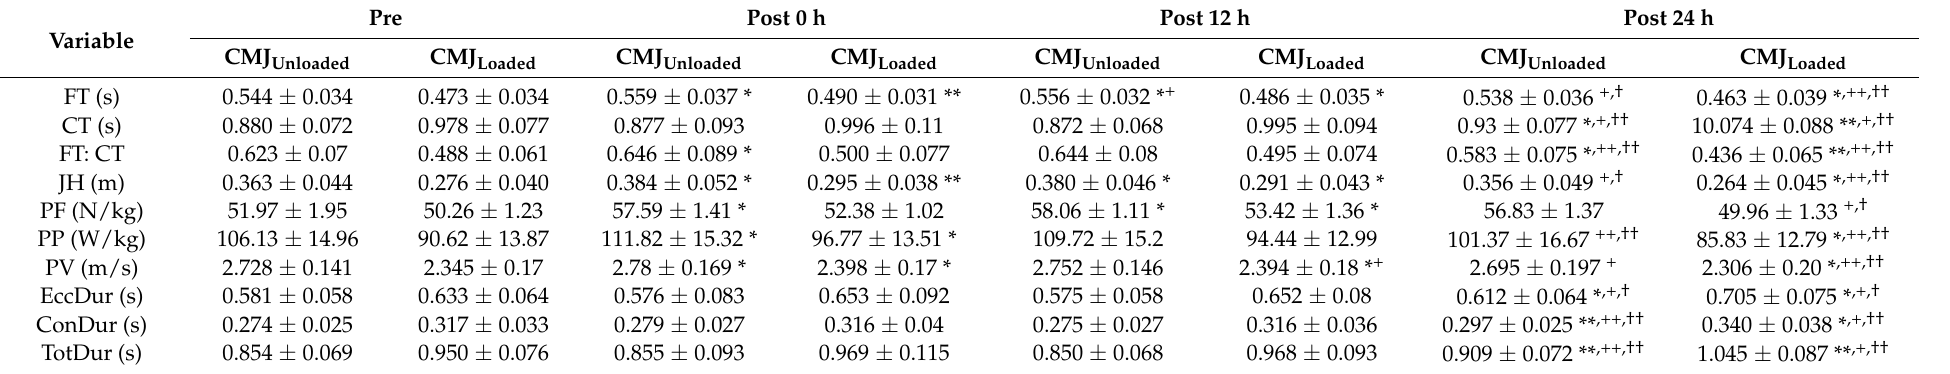
Table 1. Changes in Countermovement Jump Kinematics and Kinetic Parameters at Different Timepoints after Judo